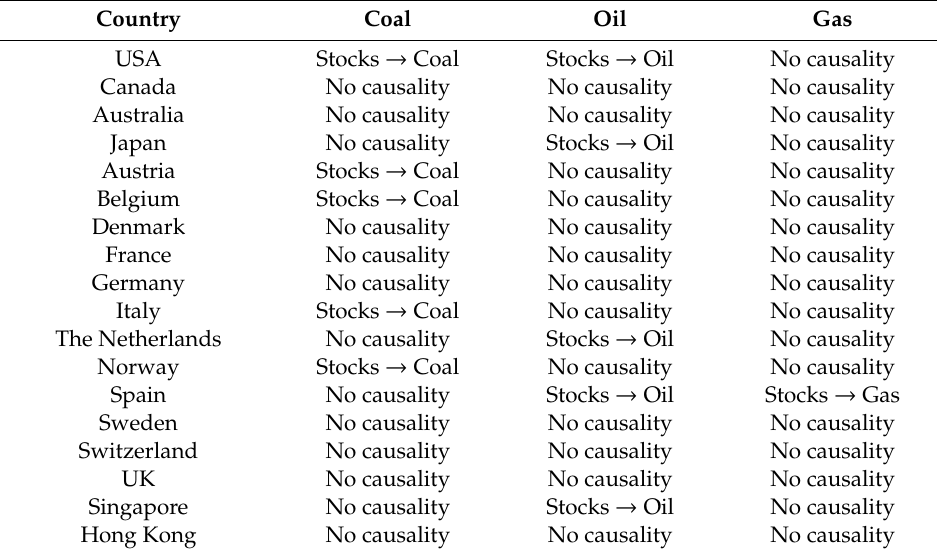
Table 24. Unidirectional granger causality results.